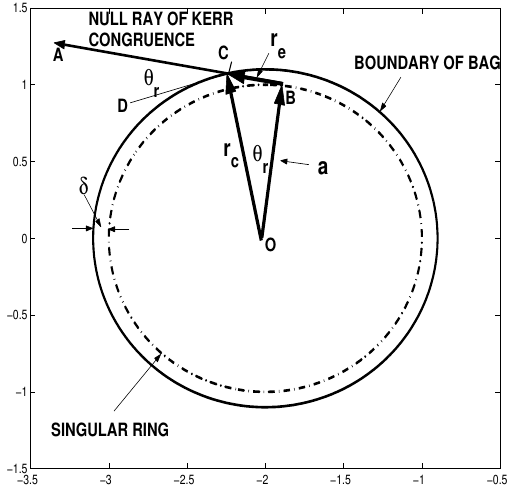
Figure 5. KN disk as a carrier of the orientifold string in the static t = const . picture. Kinematic relations in the equatorial plane of the KN disk. The shown out-going light-like beam of the Kerr congruence k µ is tangent to th Kerr singular ring and crosses the edge of the disk at angle θ r = arctan r e / a ≈ α